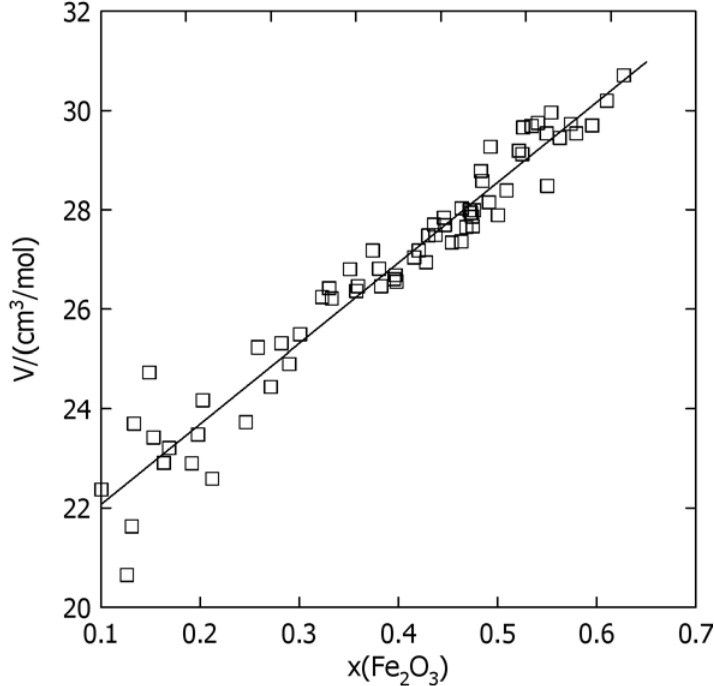
Fig. 5 Dependence of the molar volume of melts of the system CaO − Fe 2 O 3 -Cu 2 O on the content of Fe 2 O 3 at the temperature of 1573